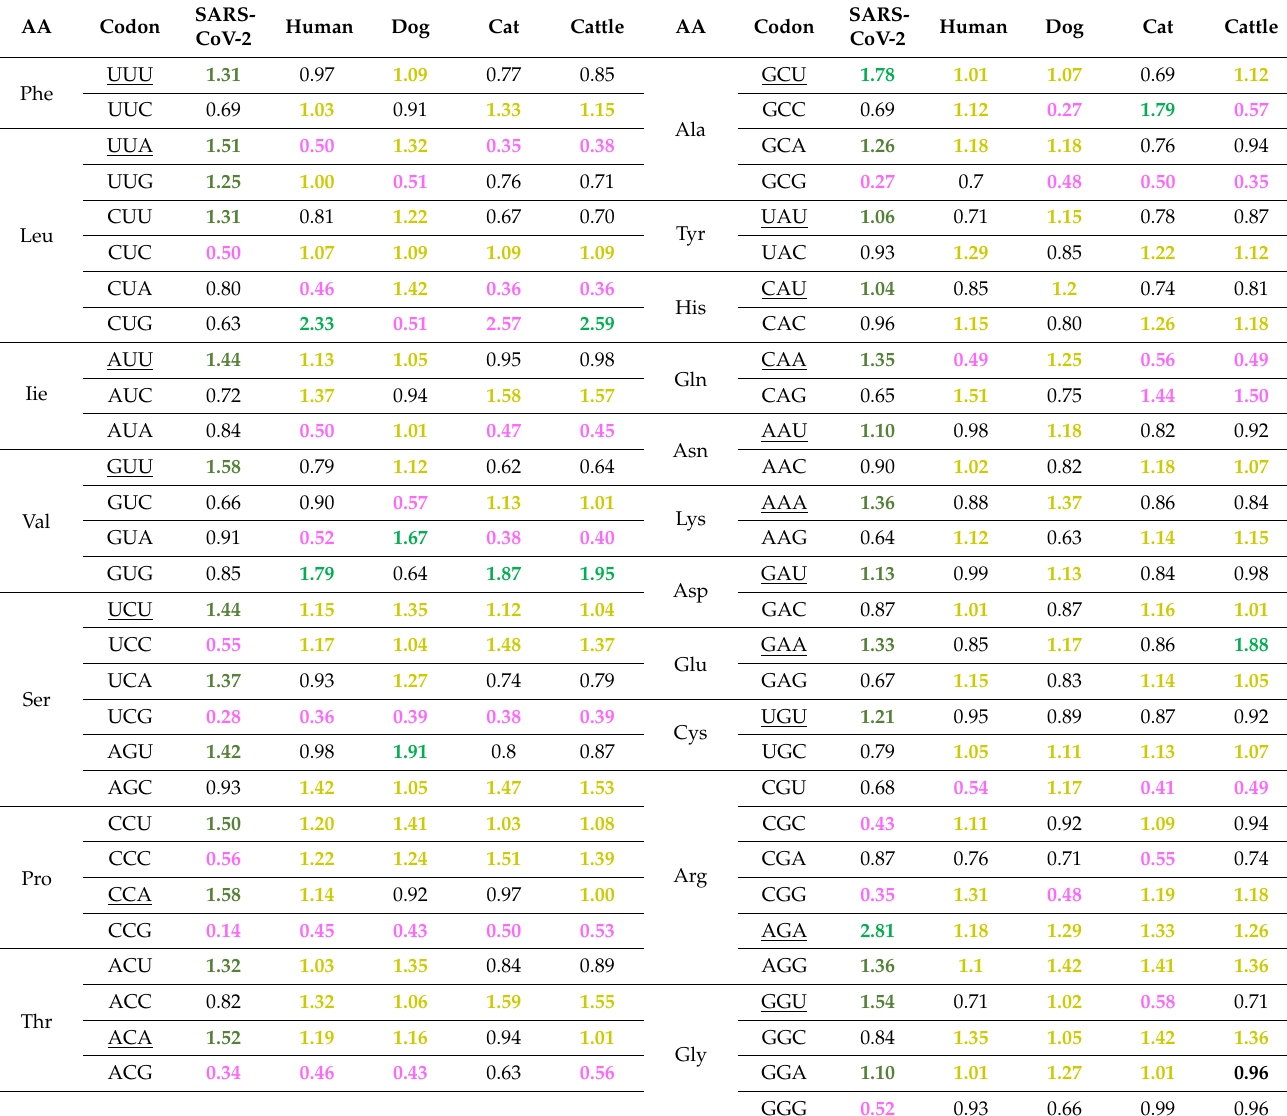
Table 1. The Relative synonymous codon usage (RSCU) value of 59 codons encoding 18 amino acids of SARS-CoV-2 virus with their hosts Homo sapiens, dog, cat, and cattle’s RSCU values